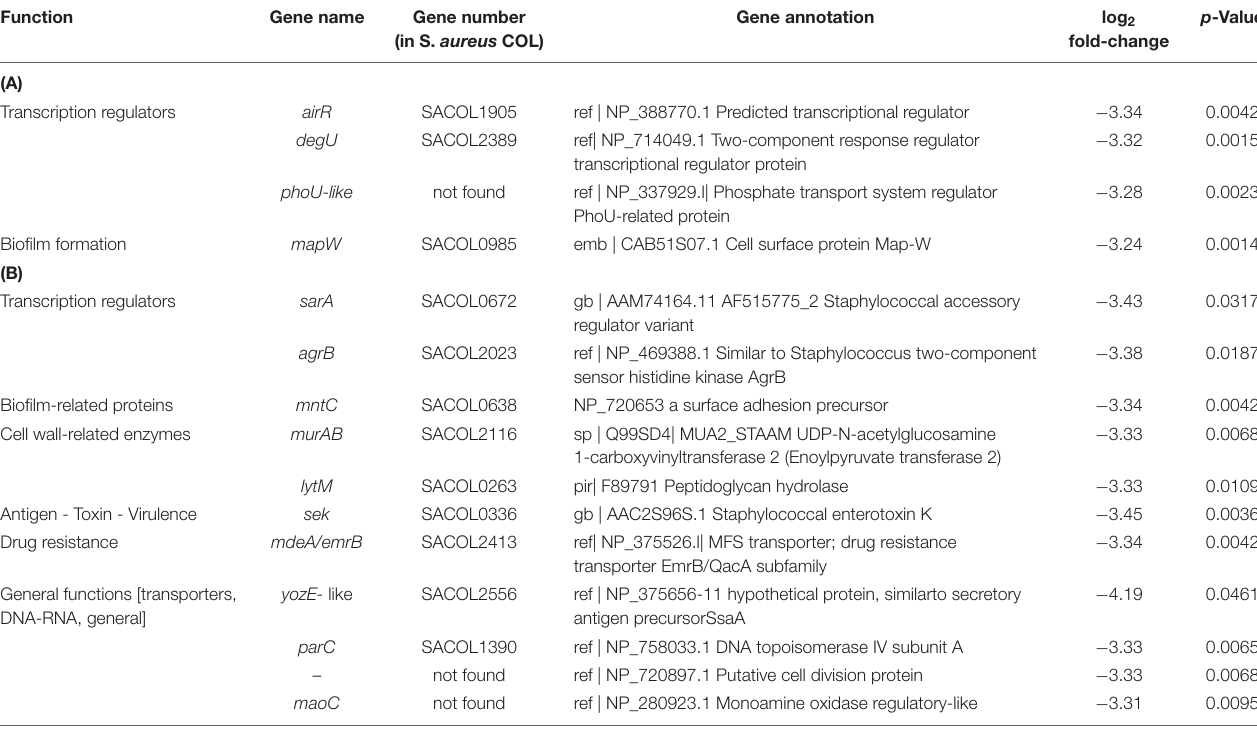
TABLE 3 | Significantly down-regulated genes at pH 9 in S. aureus COL biofilm-associated (A) and planktonic cells (B) ( p <